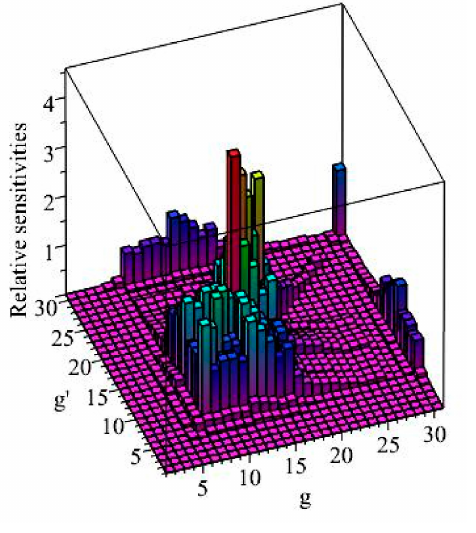
(cid:16) (cid:17) (cid:48) σ g , σ g , g , g (cid:48) = 1, ... ,30, for 239 Pu. t , i = 1 t , k = 1